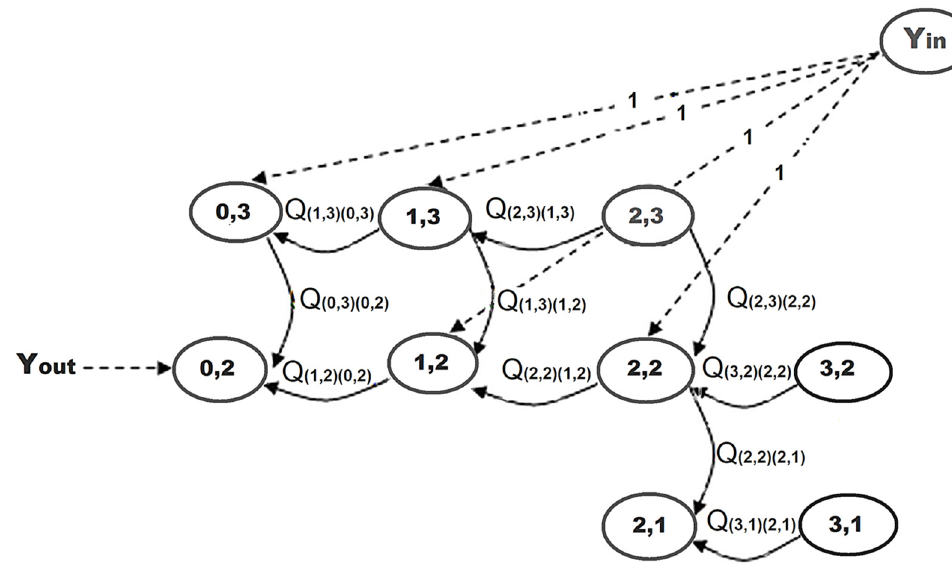
Figure 4. First case of transition from states (0,3) or (1,3) or (1,2) or (2,2) into state (0,2).